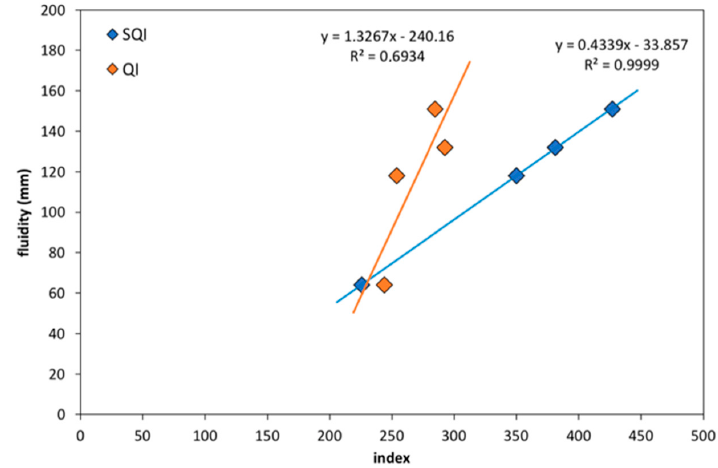
Figure 13. Fluidity change with different indices.